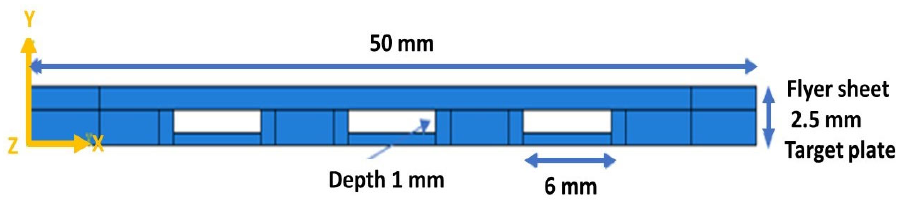
Figure 7. Flyer sheet and target plate assembly in ABAQUS.